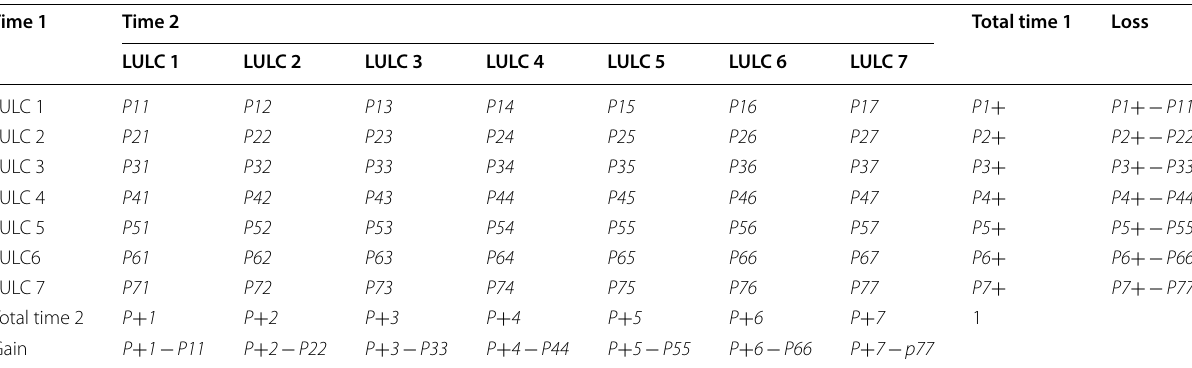
“P” refers to any conversion from one land use/cover (LULC) to another and the number refers to columns and rows of LULC